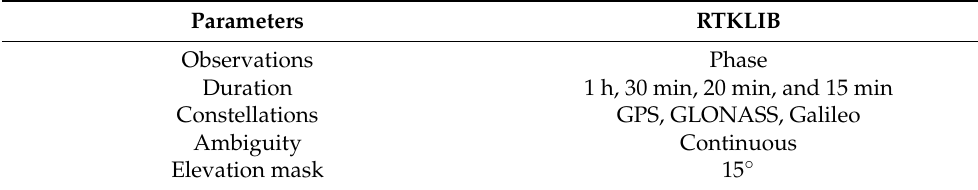
Table 1. Used parameters in the data processing.